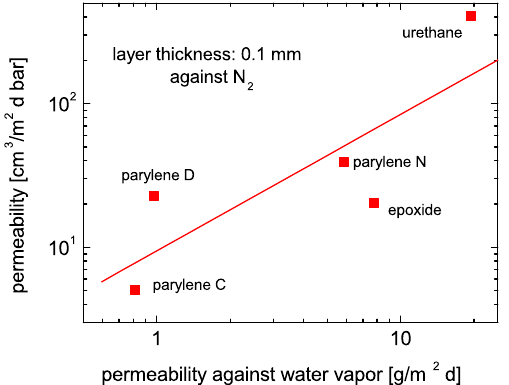
Figure 9. Barrier properties of some derivates of